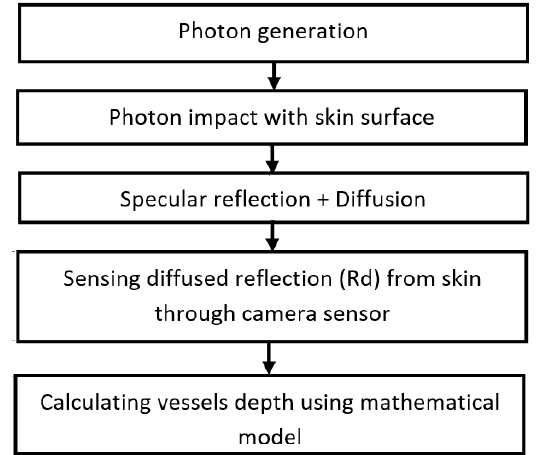
Figure 2. Block diagram of proposed method for blood vessel’s depth estimation.